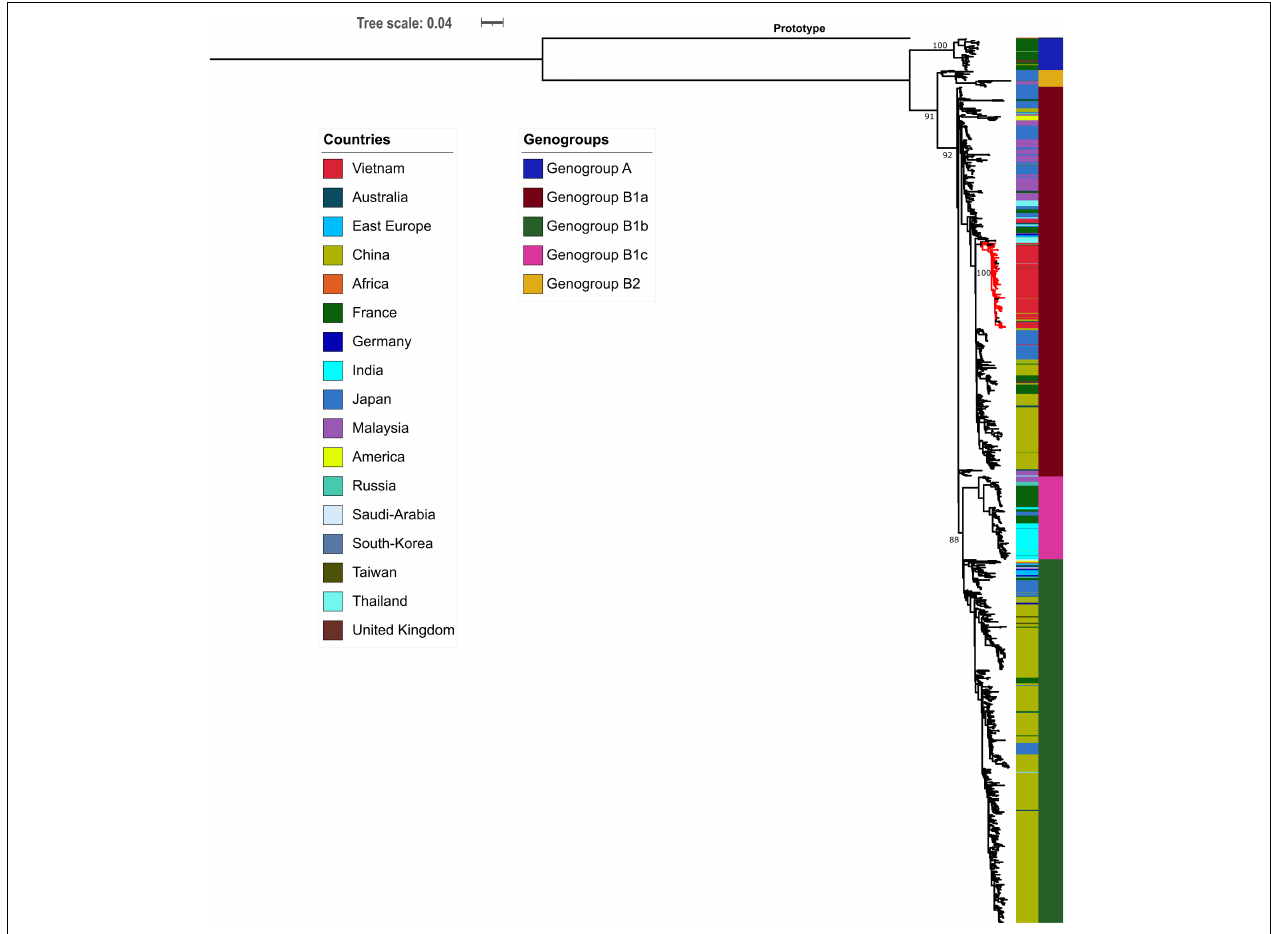
FIGURE 2 | Maximum likelihood tree of CVA16 of Vietnam and global strains based on VP1 sequence. Vietnamese isolates (red-colored branch) belong to genogroup B1a containing strains from China, Thailand, Malaysia, Japan, France, and